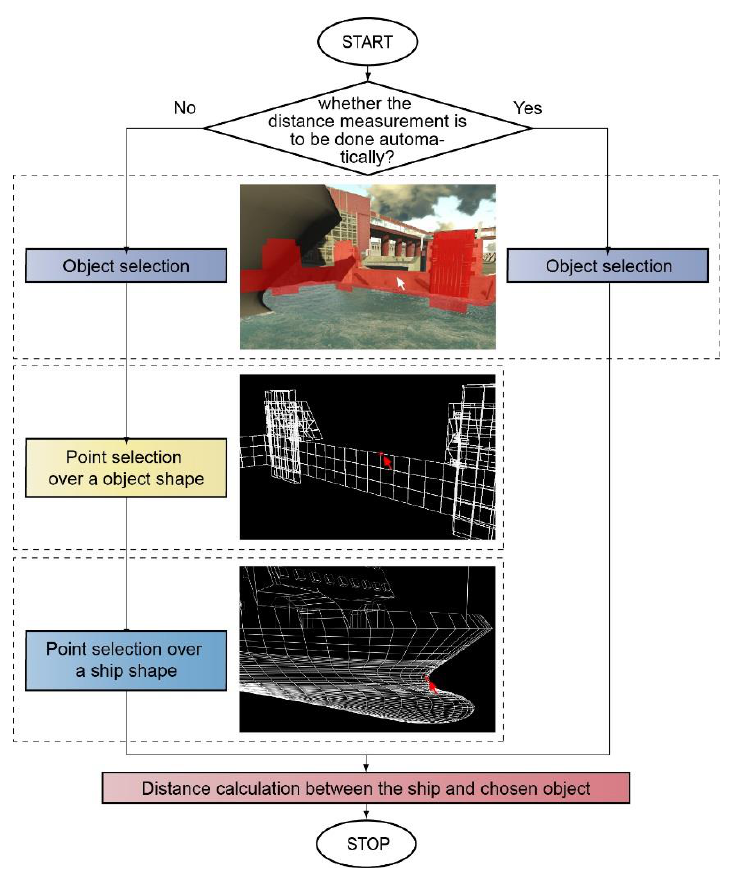
Figure 9. The algorithm of the procedure for the automatic measurement of distance between the ship’s hull and the object. hull and the